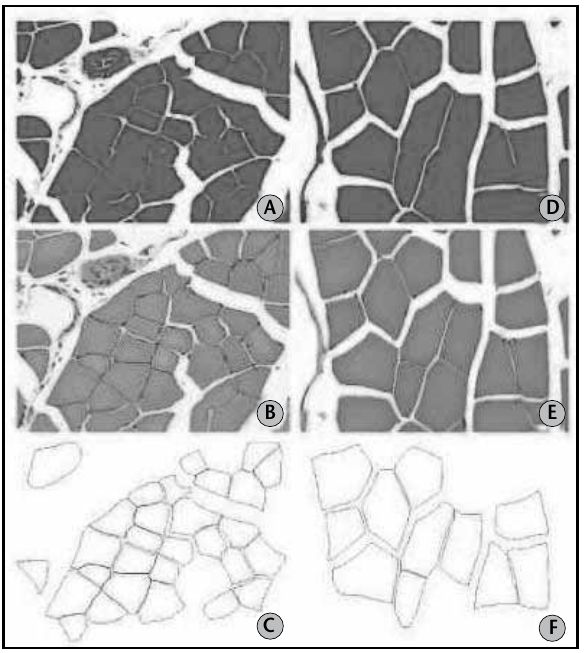
Figura 2 – Dosagens bioquímicas de AST, ALT, FA, GGT e Alb